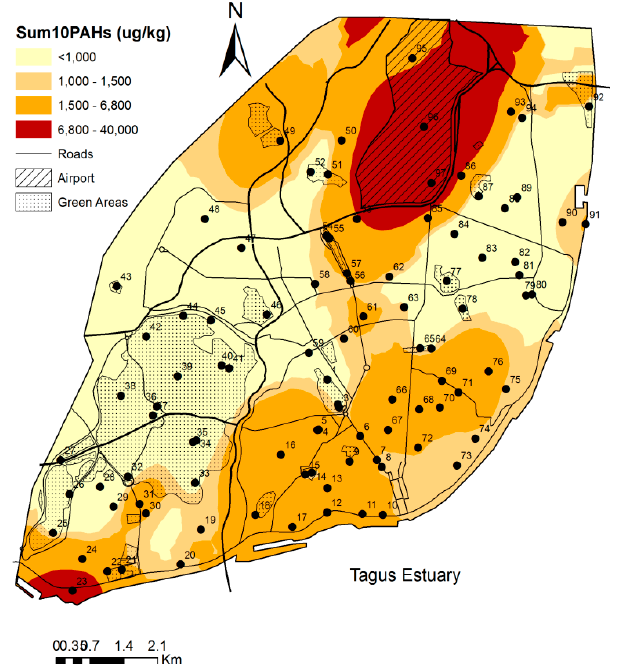
Figure 3. Contour map (interpolated by ordinary kriging) for the Sum10PAHs corrected to 10% of organic matter; the class limits correspond to the Dutch guidelines: target (1000/1500 µg kg − 1 ), maximum residential (6800 µg kg − 1 ), and intervention values (40,000 µg kg − 1 ).